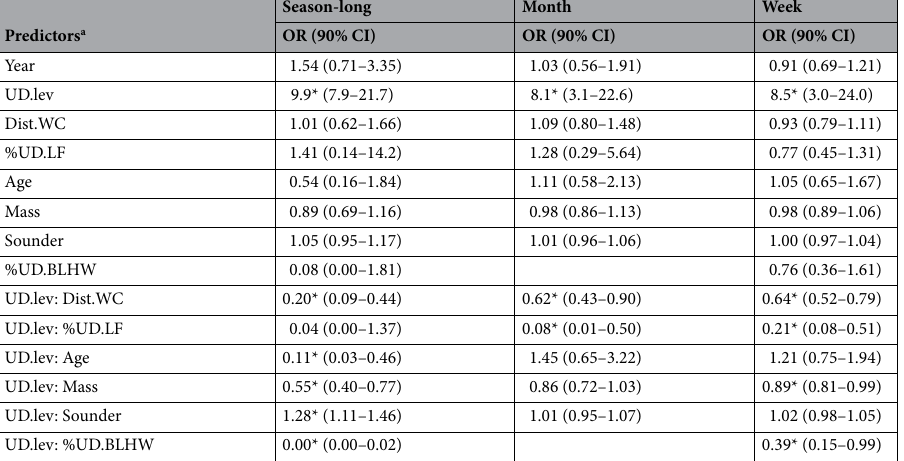
Table 3. Odds ratio estimates (OR) and 90% confidence intervals (90% CI) for the top supported model of three-dimensional overlap of utilization distributions, estimated as the volume of intersection, for wild pigs ( Sus scrofa ) across time periods (Season-long [ n season = 2; n pigs = 14], Month [ n months = 6; n pigs = 18], and Week [ n weeks = 26; n pigs = 17]) tracked on Savannah River Site, South Carolina, USA during 2014 and 2016. Colons separating predictor names denote interaction terms and asterisks denote 90% CI of odds ratios that did not overlap 1. a UD.lev = utilization distribution (UD) contour level (i.e., 95% and 50% contours representing home ranges and core areas, respectively); Sounder = Sounder size; Mass = body mass (kg); Temp = temperature (C°); Press = barometric pressure (mb); HA.UD.LF = hectare (ha) of UDs within the landfill boundary; %UD. LF = percent of UDs within the landfill; HA.UD.BLHW = ha of UDs within bottomland hardwoods; %UD. BLHW = percent of UDs within bottomland hardwoods/wetland cover; and Dist.WC = distance from UD boundaries to the waste cells within the landfill (km).